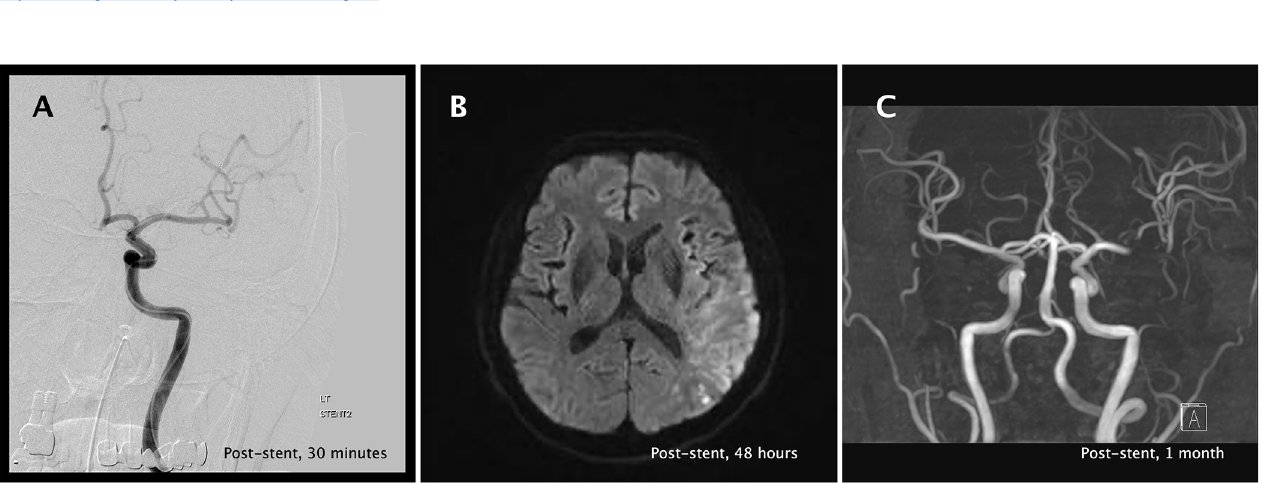
Fig 3. Radiologic images of a patient before and after RS deployment. Before IAT, diffusion-perfusion mismatch was identified by comparing the DWI to CTP images (A). Three months after the procedure, recanalization of M2 was noted on CTA. RS, rescue stent; IAT, intra-arterial thrombectomy; DWI, diffusion-weighted image; CTP, perfusion computed tomography; CTA, computed tomographic angiography.